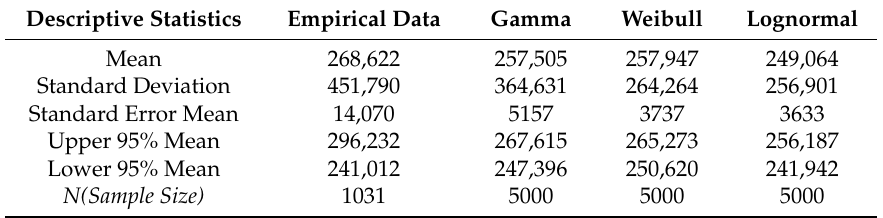
Table 9. Descriptive statistics for GLM simulation models (values shown are in